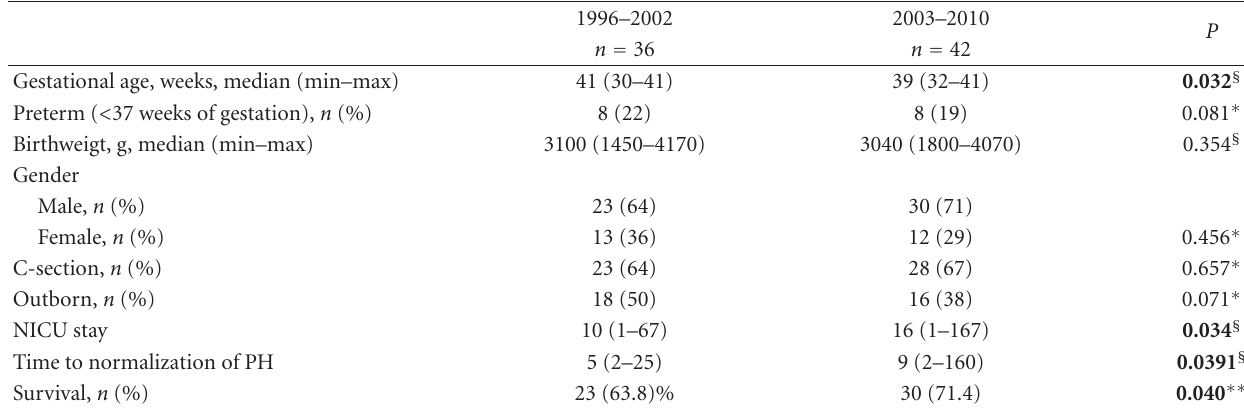
Table 4: Survival rates between two